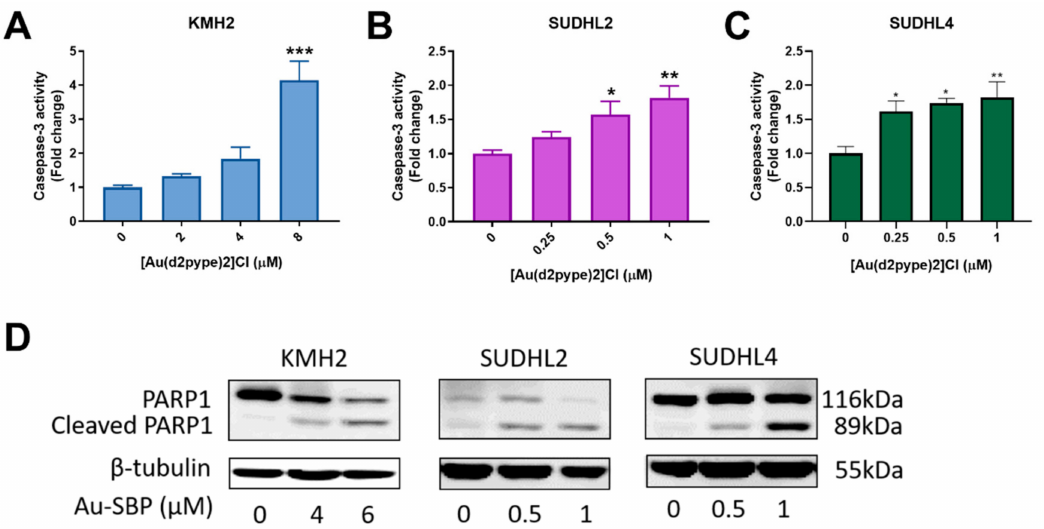
Figure 2. [Au(d2pype)2]Cl induces cell apoptosis in lymphoma cell lines. ( A ) KMH2, ( B ) SUDHL2, and ( C ) SUDHL4 cells were treated with indicated concentrations of [Au(d2pype)2]Cl for 24 h. Caspase-3 activity was measured using a fluorogenic assay. ( D ) The three cell lines were treated with the indicated concentrations of [Au(d2pype)2]Cl for 24 h. Expression of PARP1 and cleaved PARP1 was detected by western blotting. β -tubulin was used as a loading control. Caspase-3 activity was analysed by one-way ANOVA using Dunnett’s post-test. Values indicate mean ± SEM ( n = 3). * p < 0.05, ** p < 0.01, *** p <